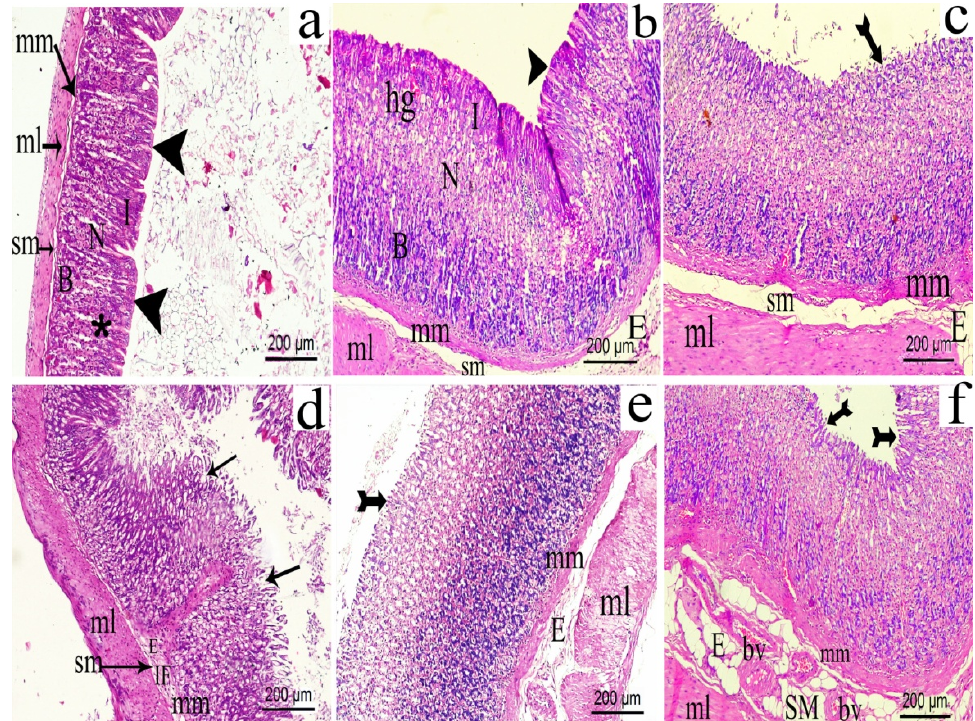
Figure 16. Photomicrograph of gastric mucosa of rat stomach sections from: ( a ) normal group; ( b ) celecoxib group; ( c ) CCI group; ( d ) indomethacin group; ( e ) H. campechianum flower extract (p.o., 200 mg/kg) group; and ( f ) H. campechianum flower extract (p.o., 400 mg/kg) group. Head arrow, bifid arrow, arrow and asterisk illustrate intact gastric epithelium, slight erosion in gastric epithelium, shedding and ulcer in gastric epithelium and gastric pit, respectively. Basic region (B); blood vessel (bv); edema (E); hemorrhage (hg); infiltration (IF); Isthmus (I); mucosa (M); muscular layer (ml); muscularis mucosa (mm); neck (N); and submucosa (sm). Scale bar, 200 μm × 100.